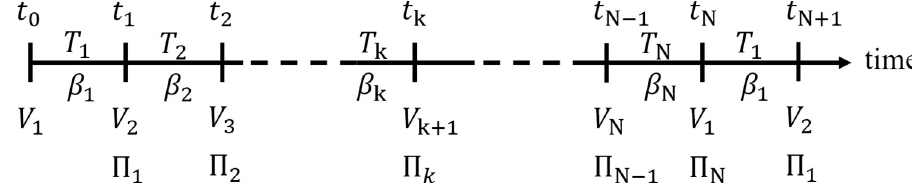
Fig 1. Interval index reference for periodic problems. Return ( P value V k refers to the beginning of interval k